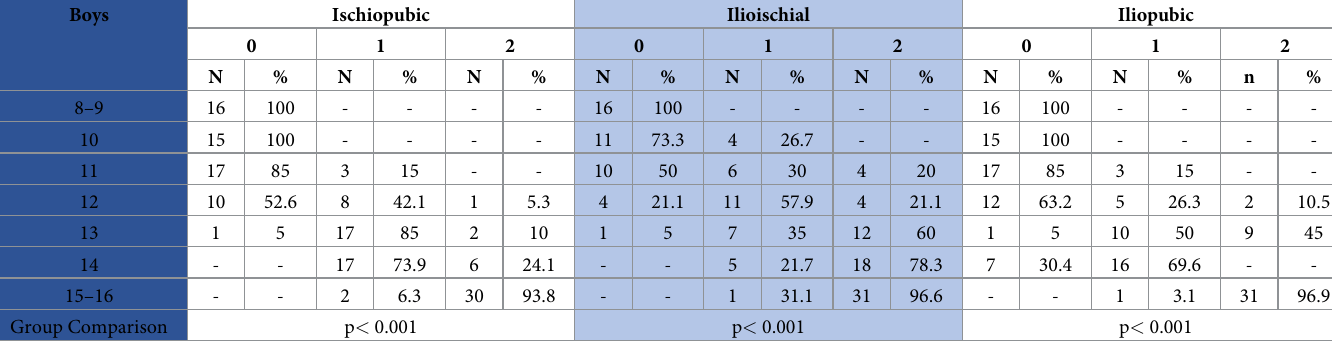
Physical, sexual, skeletal, and dental maturity indicators are frequently used for age estimation [14]. Hand and wrist radiography is the most commonly used method to evaluate skeletal maturity or bone age [15,16]. For many years, the Radiographic Atlas of Skeletal Development of the Hand and Wrist by Greulich and Pyle or Tanner-Whitehouse Atlas has been used for age estimation depending on the bones’ presence, size, and shape in hand and wrist [17,18]. This study presented the subject by using pelvis computed tomography (Figs 1–6) for forensic Table 2. Ischiopubic, ilioischial, and iliopubic synchondrosis junction points in boys by age.